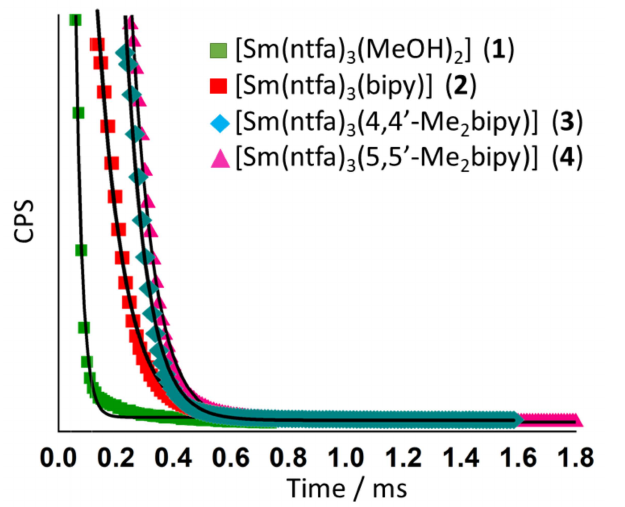
Figure 5. Photoluminescence time decay of compounds 1 – 4 monitored at the maximum emission wavelength of 649 ± 2 nm ( 4 G 5/2 → 6 H 9/2 ). Solid lines represent the monoexponential fitting of the decay